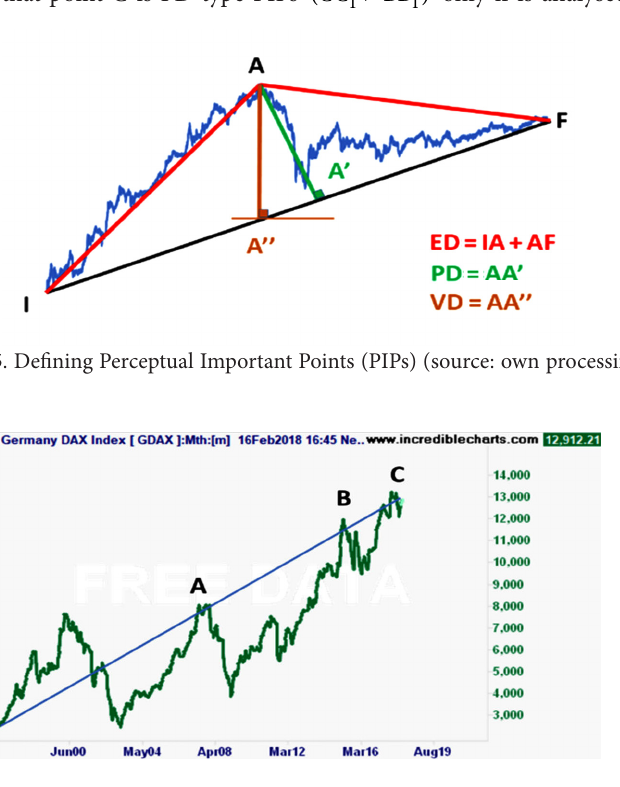
Figure 6. Flaws in detecting PIPs on DAX (source: own